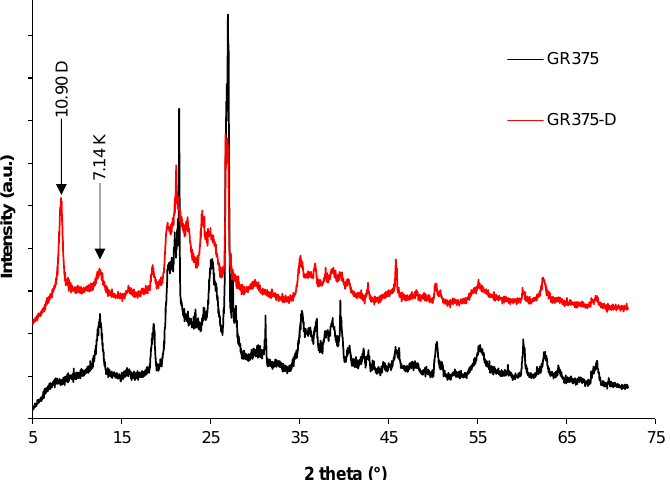
Figure 1. XRD pattern of raw (GR375) and DMSO intercalated (GR375-D) kaolinite. An intercalation ratio (I.R) value of 60.6% is calculated by Equation (1), assuming, for both expanded and unexpanded phase, the same degree of particle orientation [12,29].